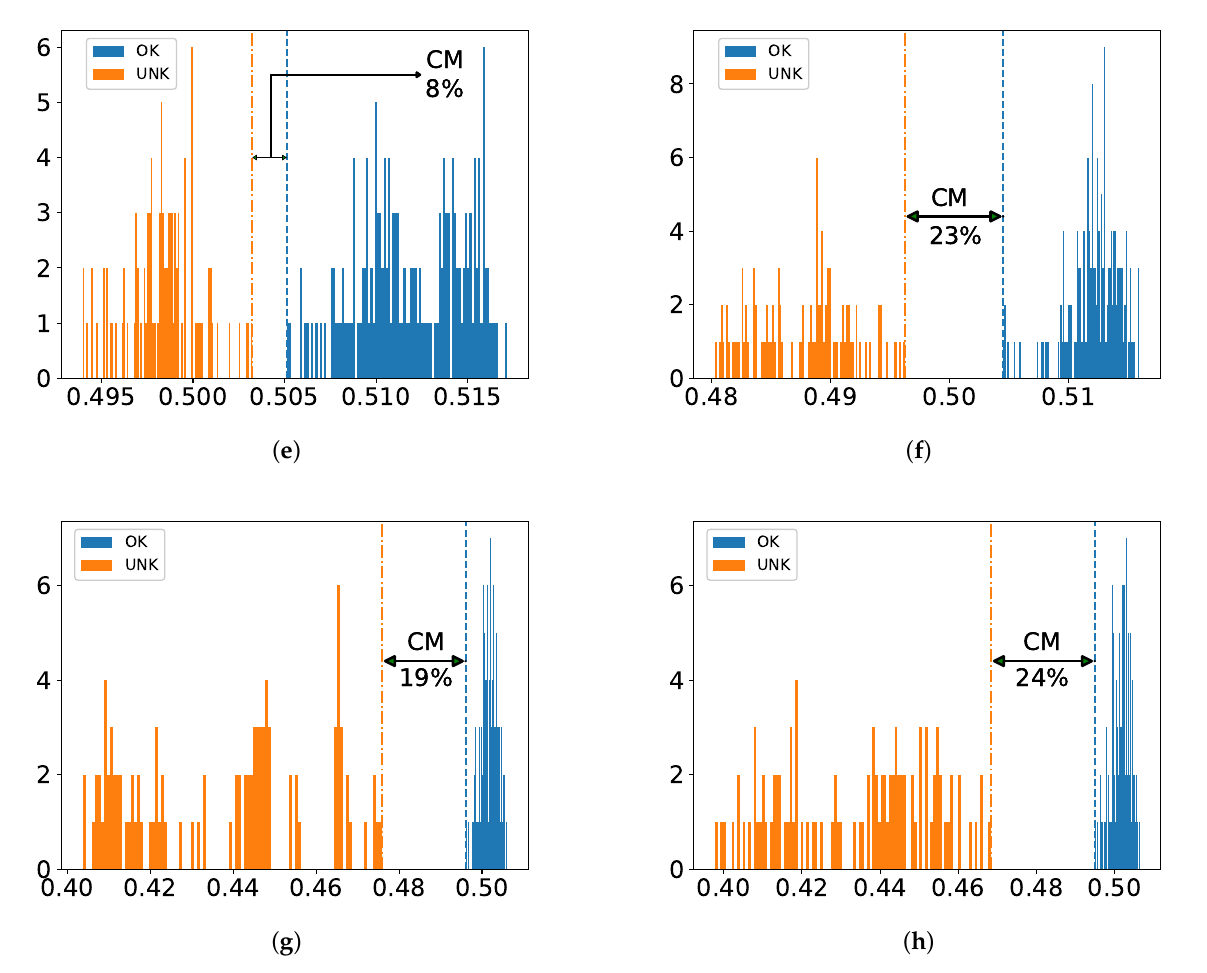
Figure 8. Histogram of one-class classifiers with the dataset RC2-75k. CM in Equation (1) is reported if available. Values on the x -axis are normalized classifier scores according to Equations (2)–(5). ( a ) HMM with PFA; ( b ) HMM with SFA; ( c ) SVM with PFA; ( d ) SVM with SFA; ( e ) IF with PFA; ( f ) IF with SFA; ( g ) AE-BN with PFA; ( h ) AE-BN with SFA.